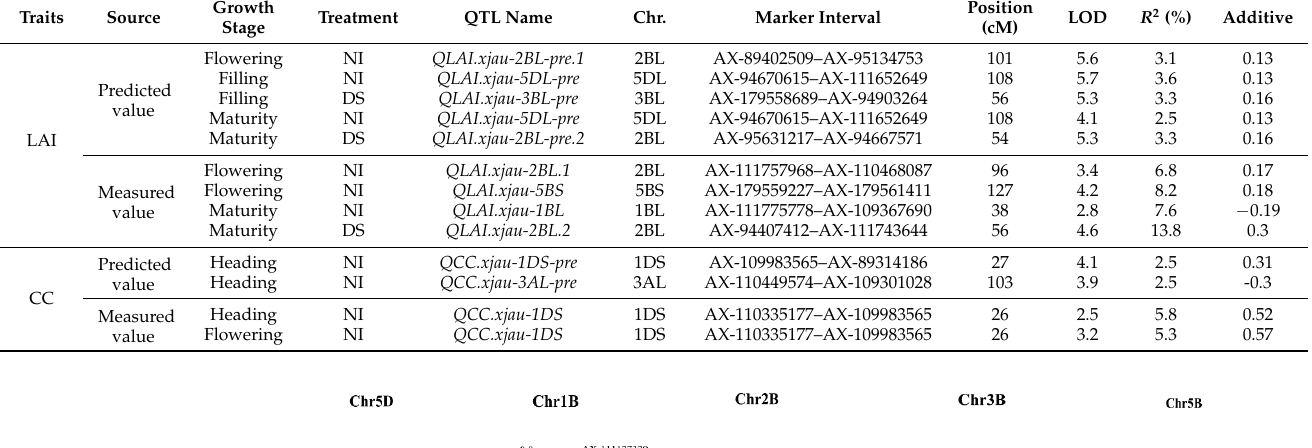
Table 6. Information on QTLs related to leaf area index (LAI) and chlorophyll content (CC) based on RIL population of cross Worrakatta × Berkut.